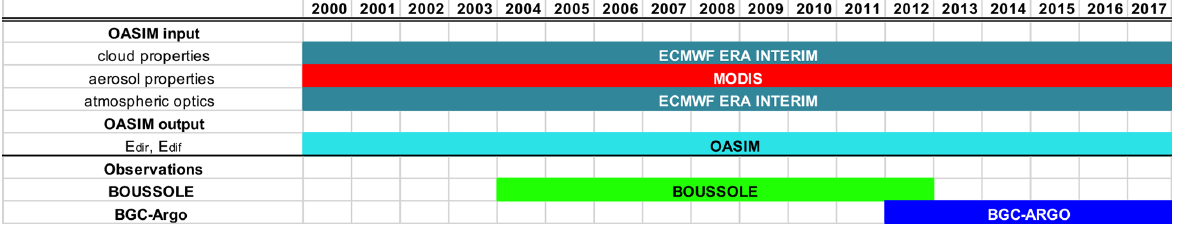
Figure 3. Availability of the model input (cloud, aerosol and atmospheric data) and radiometric output data ( E dir and E dif ) and corresponding observational datasets for the validation in the present work. The acronym definitions are reported in Sect. 2.1, 2.2 and